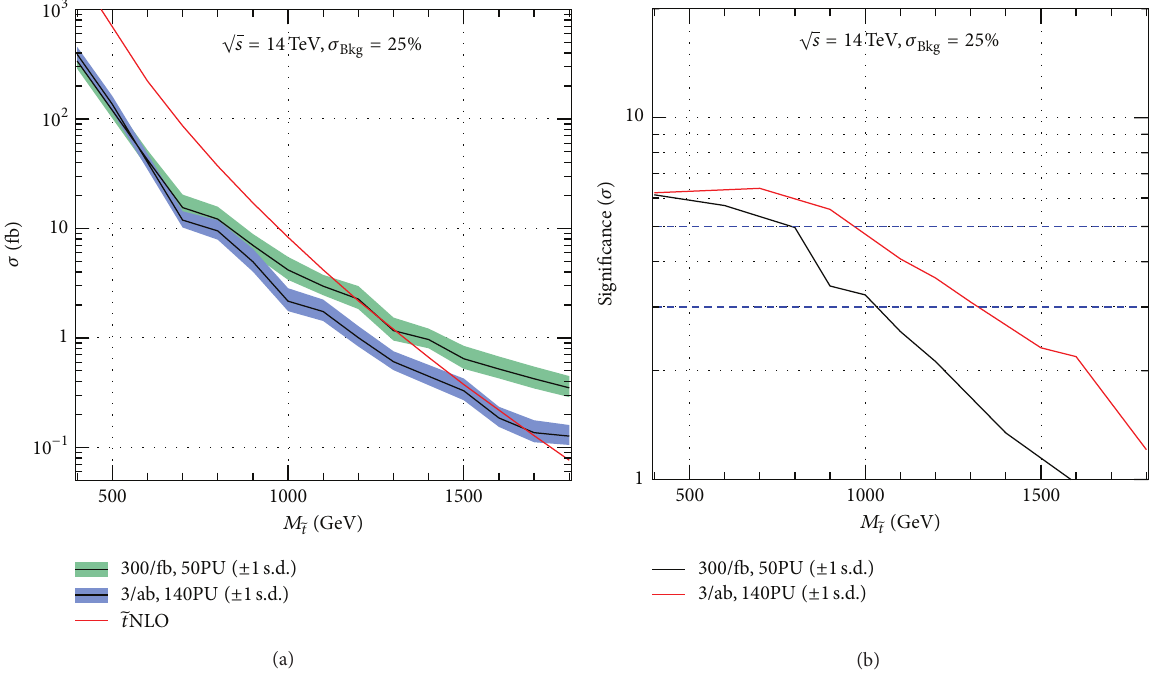
Figure 7: Exclusion (a) and discovery reach (b) for the High Luminosity LHC for the ̃ 𝑡 - 𝜒 RPV simplified model [6]. In the two panels, the two curves correspond to different hypothesis for integrated luminosity and average number of Pile Up (PU)